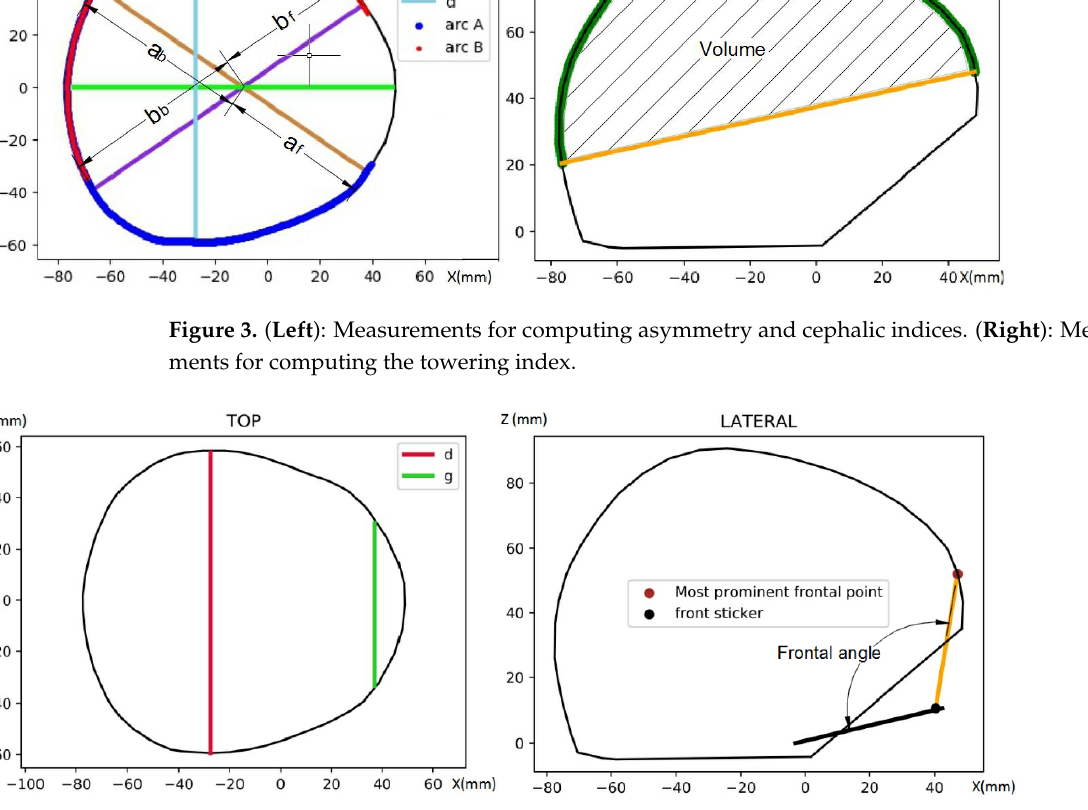
Figure 4. ( Left ): Measurements for computing the metopic index. ( Right ): Measurements for computing the frontal